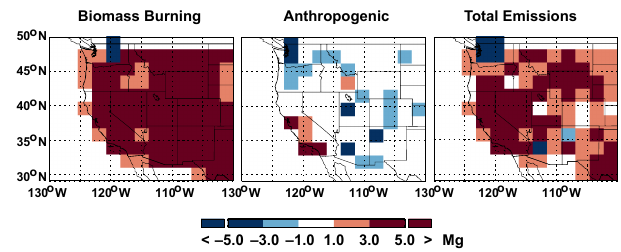
Figure 6. Emissions of BC: Case 8 minus Case 1 (Table 1) at 2 ◦ × 2.5 ◦ for August 2006. Case 8 is same as Case 1, except with the a priori biomass burning emissions uniformly increased by 2.5Mg in every model grid